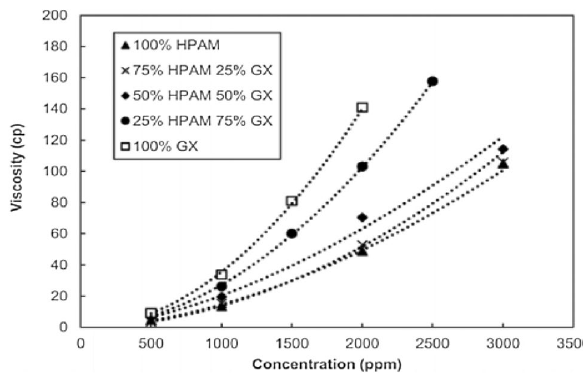
Fig. 6 Viscosity versus concentration of HPAM + Xanthan (GX) mixture in 17.1 g/l brine with 260 mg/l of [Ca] (2+) and 280 mg/l of [Mg] (2+) (from Delamaide 2018)